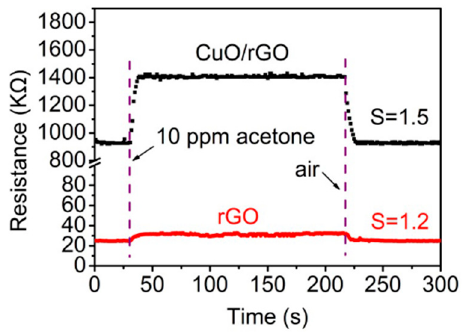
Figure 16. The resistance curves of CuO/rGO and pure rGO sensors to 10 ppm of acetone [84]. In 2015, Singkammo et